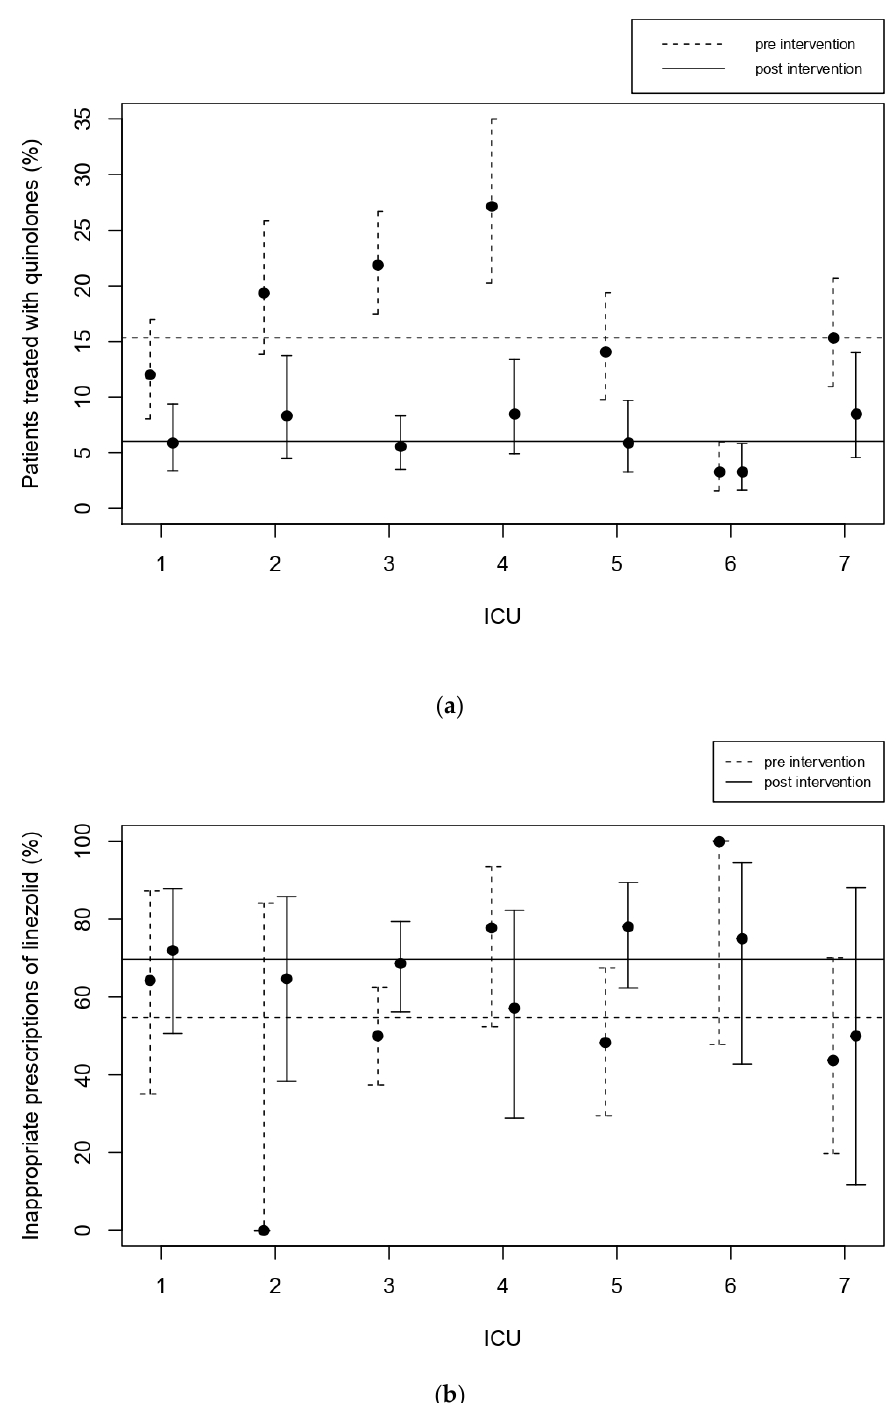
Figure 3. Use of quinolones ( a ) and inappropriate prescriptions of linezolid ( b ) for the participating centers, pre ‐ (dashed line) and post ‐ intervention (solid line). The horizontal line indicates the average.